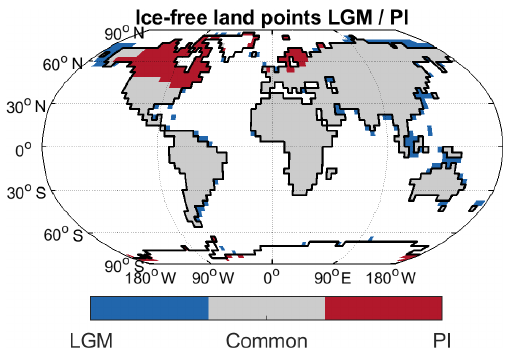
Figure A1. Ice-free land points for LGM and PI time slices, as well as grid points common to